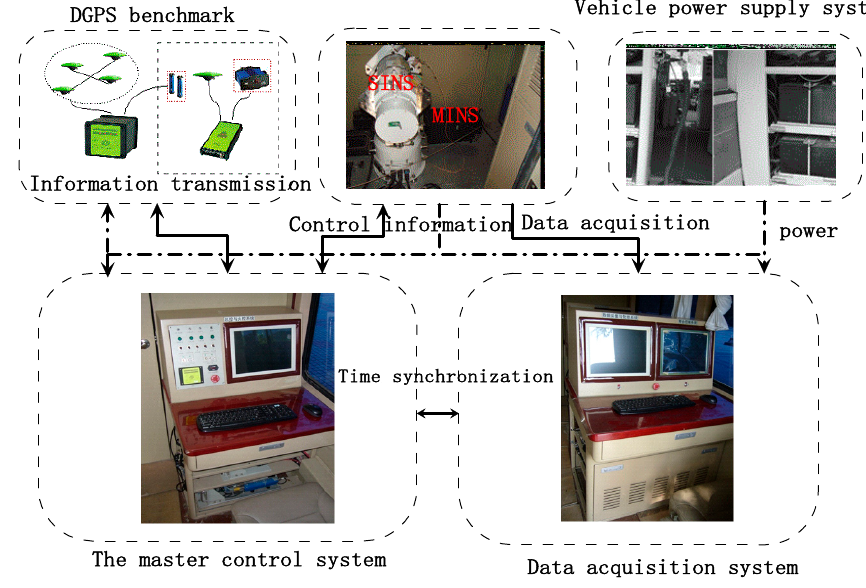
Figure 14. Test platform block diagram.